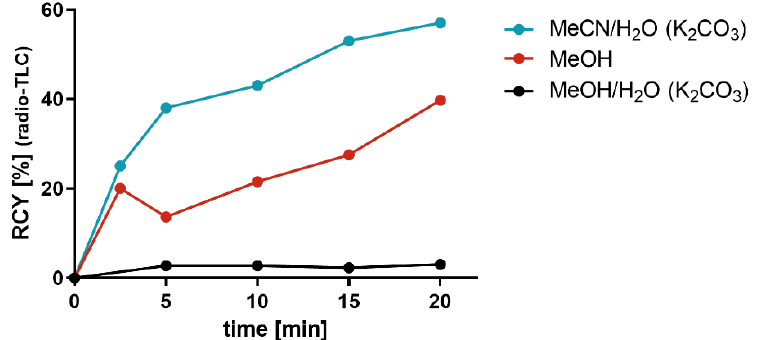
Figure 1. Time dependency of the RCY on the radiosynthesis of [ 18 F]2a (Table 2) when [ 18 F]fluoride was eluted from the anion-exchange cartridge by various solvent was eluted from the anion-exchange cartridge by various solvent systems.